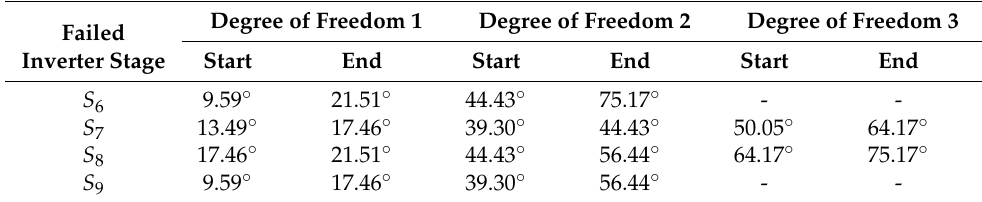
Table 3. Degrees of freedom for